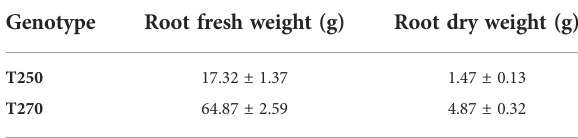
TABLE 1 Root biometric parameters in control treatment.